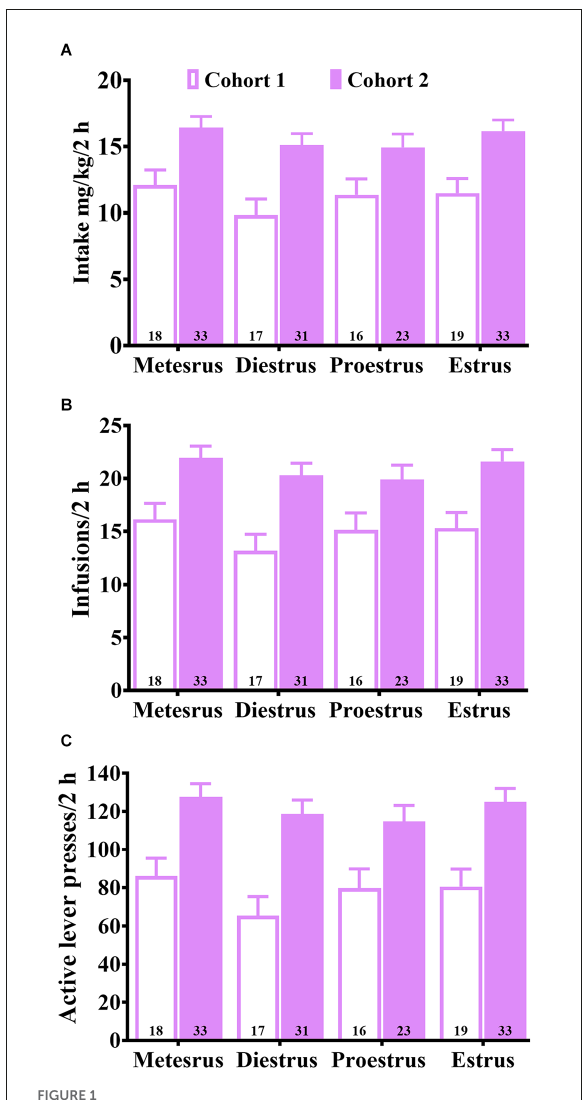
FIGURE1 Average baseline (mean ± SEM) of daily cocaine intake (mg/kg) (A) , infusion rates (B) , and active lever response rates (C) during trainingforcohorts1and2ateachestrouscyclephasemeasured prior to the CP94253 test phase. Both cohorts were given access to 0.75 mg/kg, i.v. cocaine on an FR5 schedule of reinforcement during training. The estrous cycle phase did not affect any of the